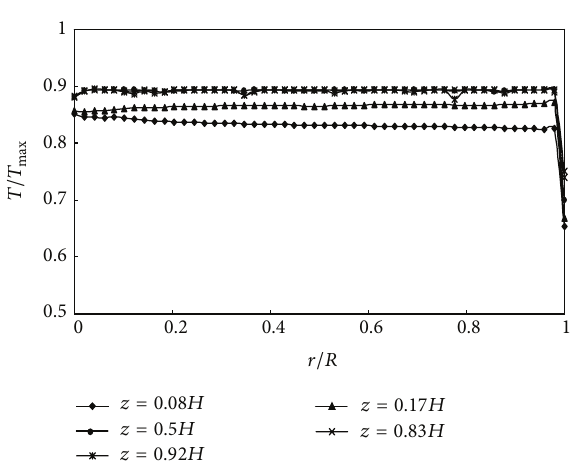
Figure 14: Profile of radial dimensionless